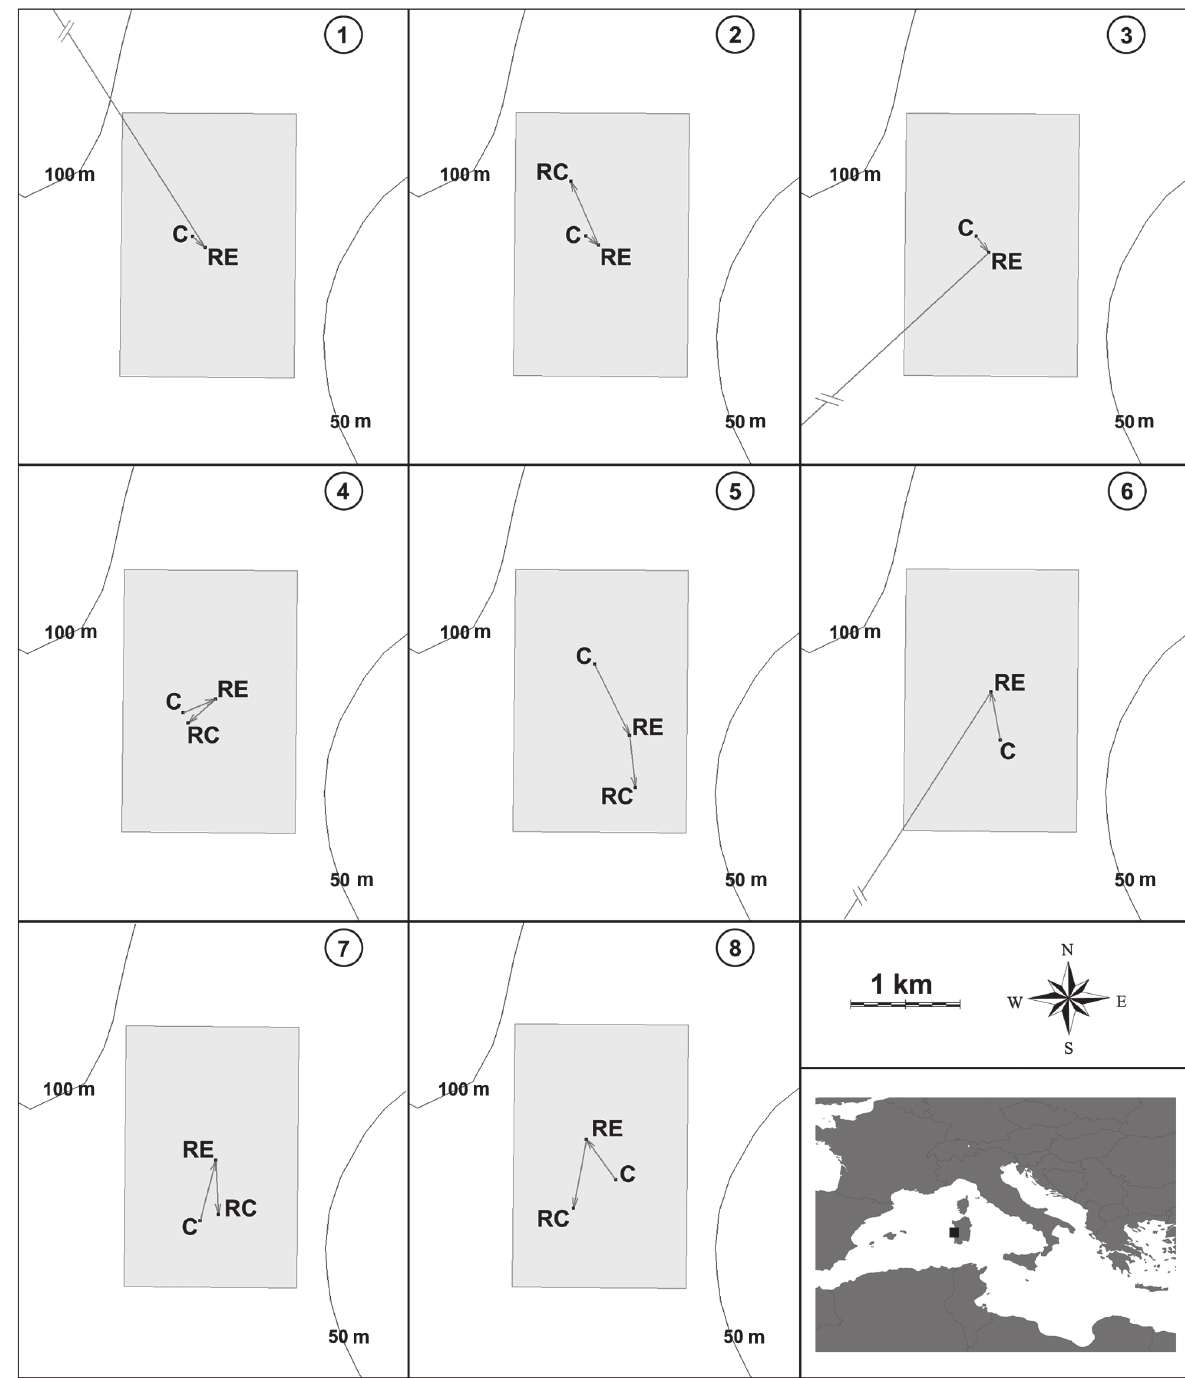
Fig . 2. – Movement patterns of the eight tagged lobsters inside and around the protected area (rectangular area). legend: inside the circle the number of the tagged lobster; C, point of initial site of capture; re, point of release; rC, point of